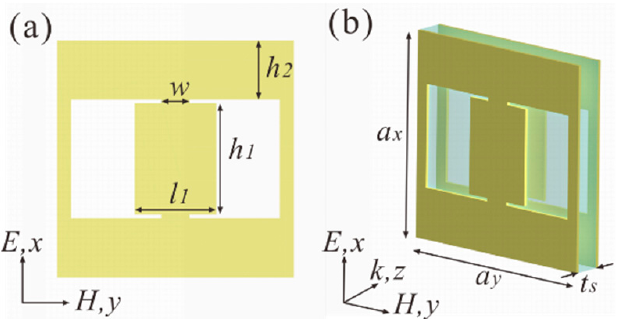
Figure 1. ( a ) Scheme of left-handed metamaterials’ (LHMs) unit cell from ( a ) front and ( b ) perspec- tive views. In which, w = 7.6 μ m, l 1 = 22 μ m, h 1 = 30 μ m, h 2 = 16 μ m, a x = a y = 64 μ m, and t s = 5 μ